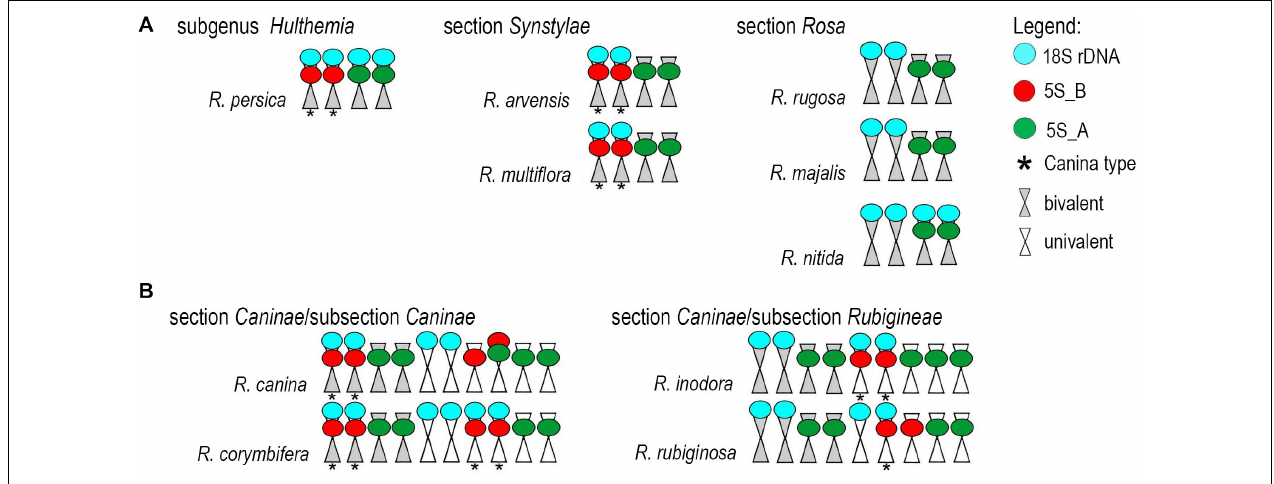
FIGURE 6 | Ideograms of chromosomes carrying the rDNA loci. (A) Diploid species. (B) Pentaploid species from section Caninae